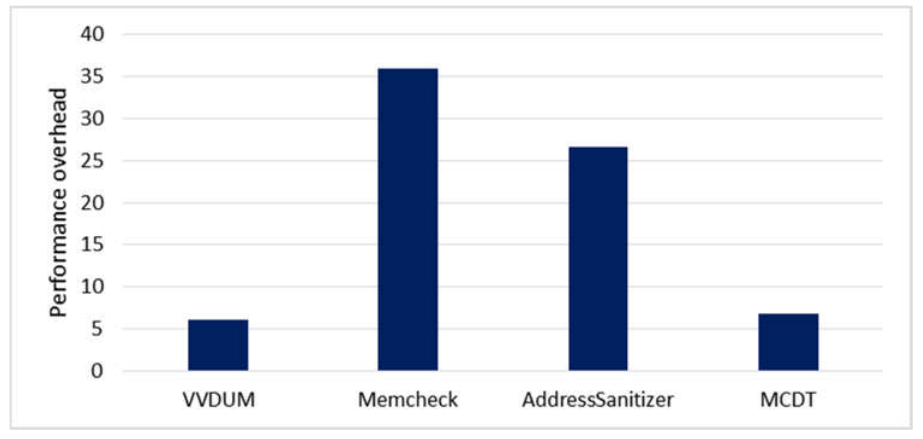
Figure 12. Performance